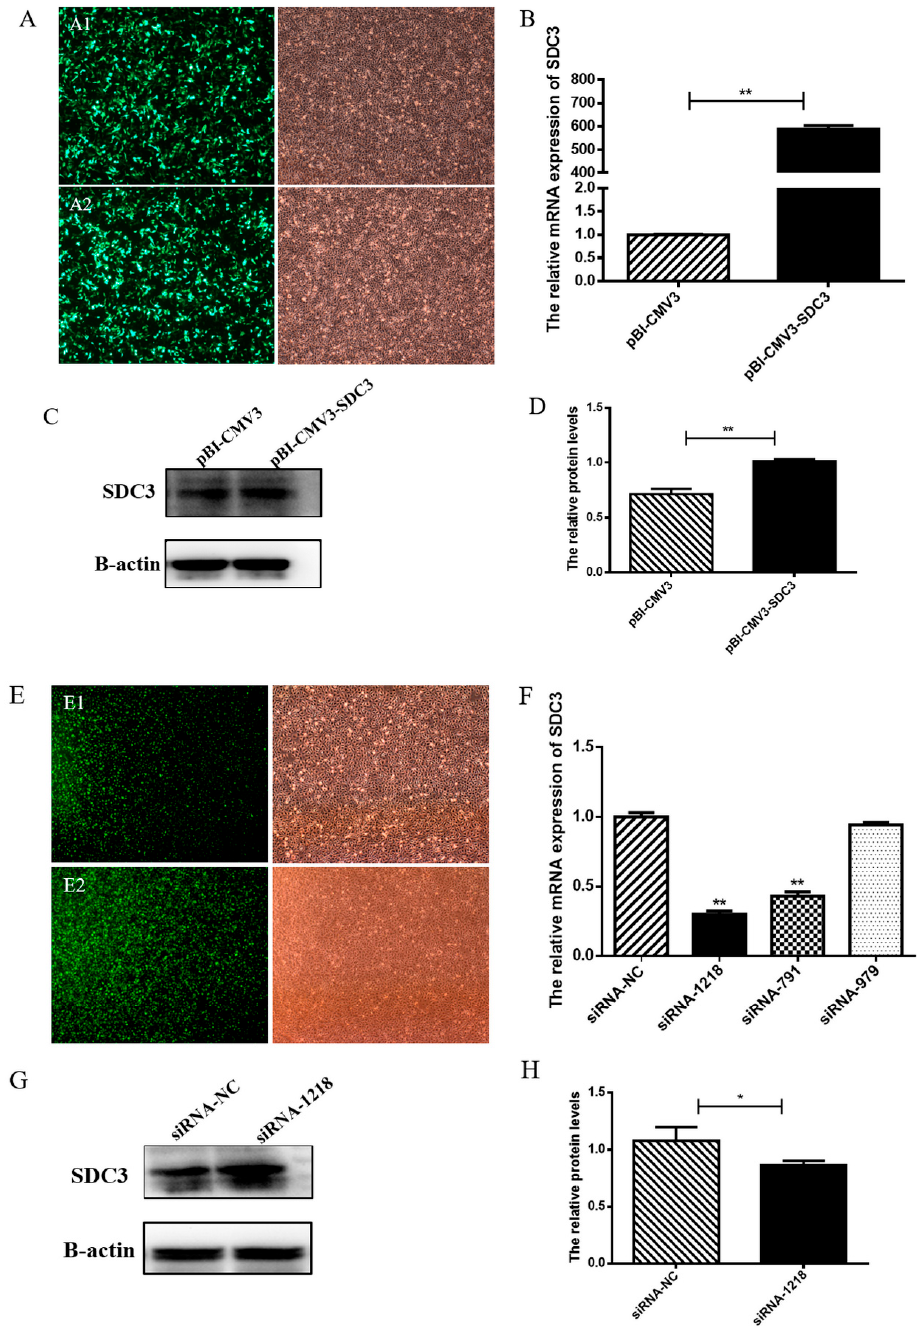
Figure 1. Identification of transfection efficiency of SDC3 overexpression and SDC3 knockout in bovine mammary epithelial cells (BMECs). The empty vector (pBI-CMV3) ( A1 ), overexpression vector (pBI-CMV3-SDC3) ( A2 ), small interference RNA (siRNA-1218) ( E1 ), and its negative control (siRNA-NC) ( E2 ) were transfected into BMECs (Magnification 40 × ). ( A , E ) Then, after 24 h, green fluorescence was observed under a fluorescence microscope (Magnification 40 × ). The expression of SDC3 in BMECs was detected by RT-qPCR and Western blot. The overexpression of SDC3 increases the transcription ( B ) and translation ( C , D ) of SDC3 in BMECs, whereas the knockout of SDC3 decreases the transcription ( F ) and translation ( G , H ) of SDC3 in BMECs. Data presented as means ± SD (n = 3). Statistically significant differences are indicated: * p < 0.05, ** p < 0.01. pBI-CMV3, siRNA-NC = nonspecific scrambled